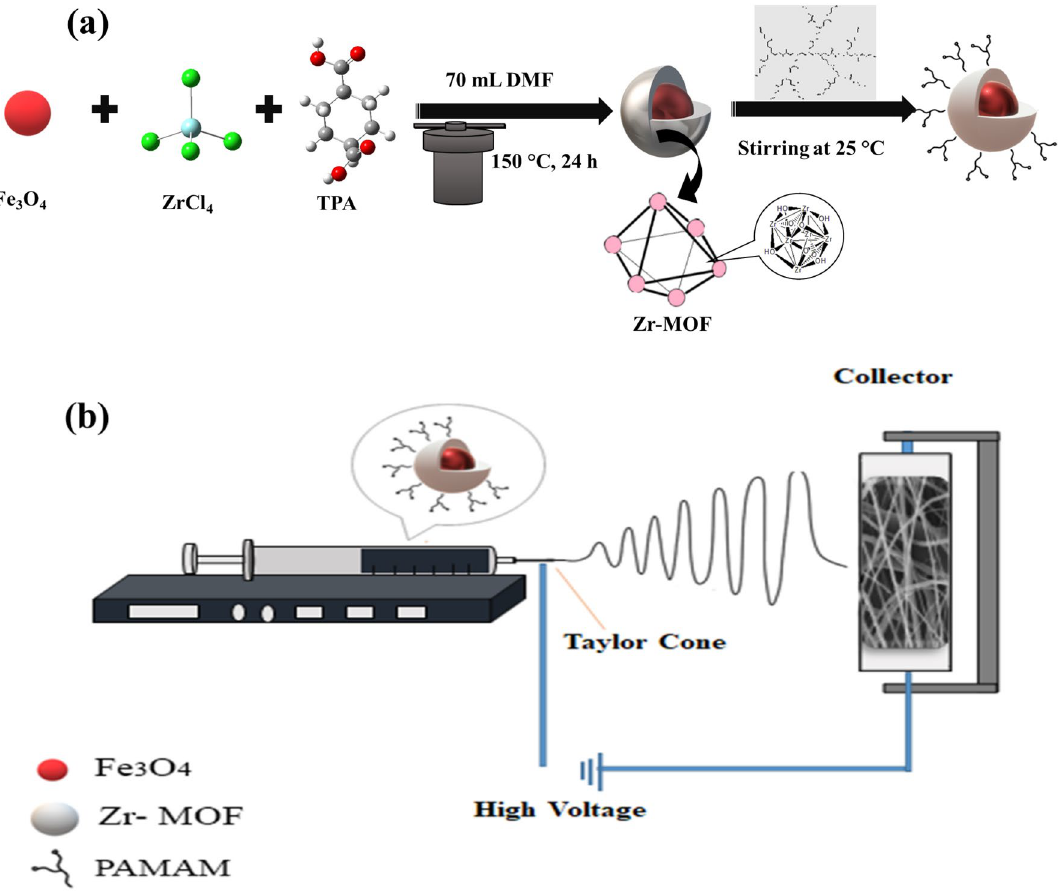
Figure 1. ( a ) The formation diagram of Fe 3 O 4 @MOF-PAMAM sorbent; ( b ) Schematic of the electrospinning